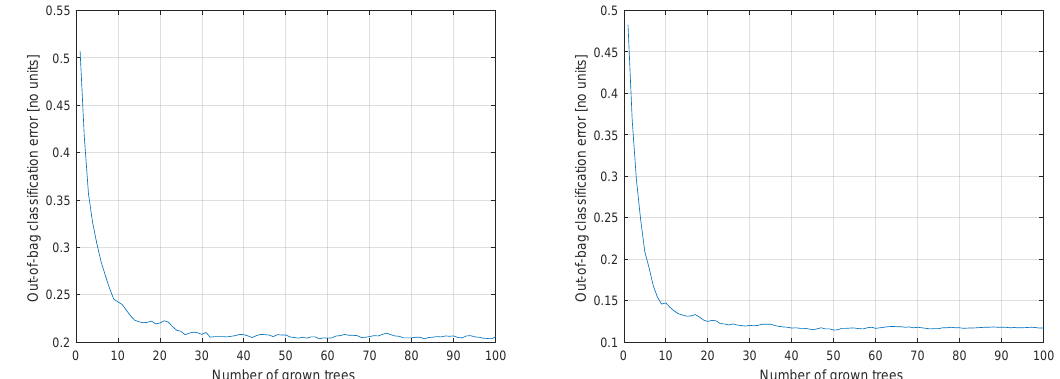
Figure 4. The effect of decreasing the number of trees on the accuracy of the Moderate classifier ( left ) and Rigorous classifier ( right ). 10 trees is a reasonable compromise between accuracy and feasibility for on-board